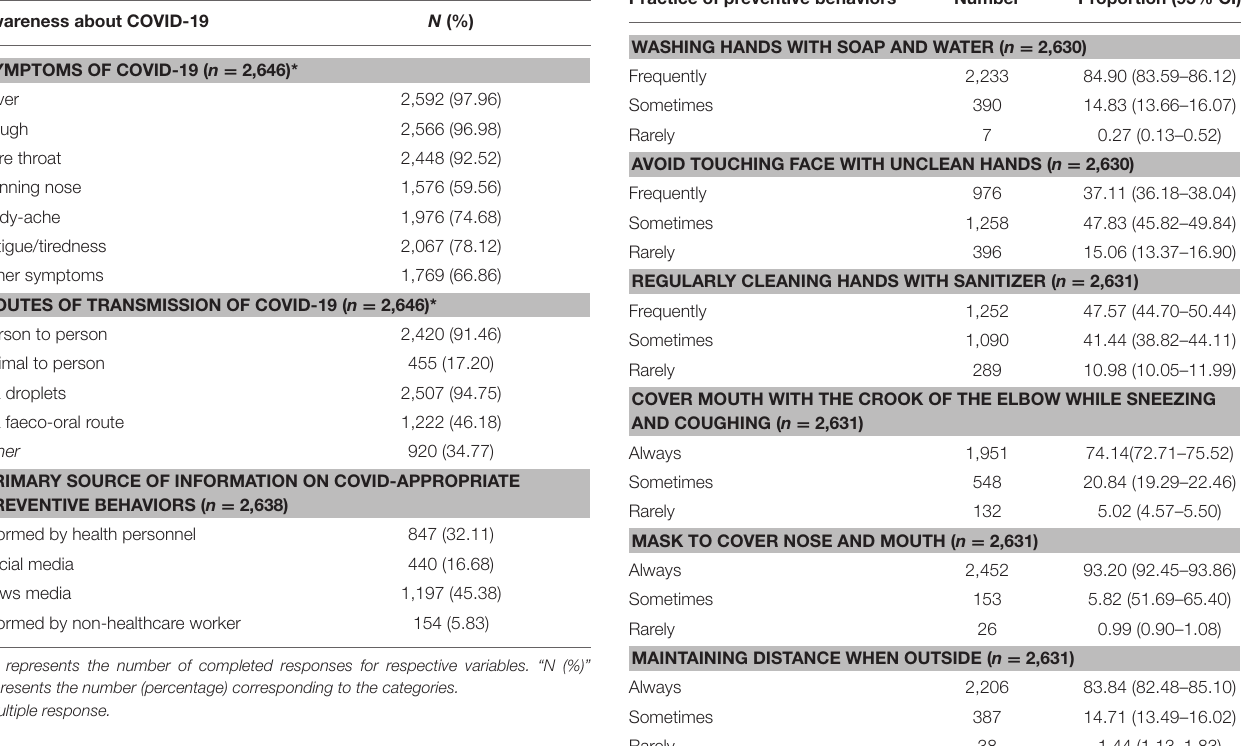
TABLE 3 | Practice of different preventive behavior as reported by the participants.